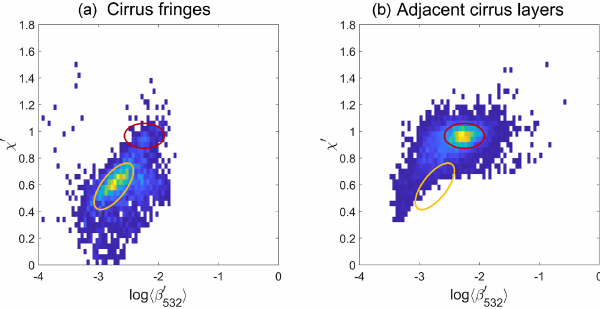
Figure 7. Layer-integrated attenuated color ratio, χ ’, vs. log 10 of (cid:105) ) , for layers the 532nm mean attenuated backscatter, log 10 ( (cid:104) β (cid:48) 532 identified as cirrus fringes (a) and for adjacent cirrus layers (b) . Or- ange probability contours for cirrus fringes and red probability con- tours for the adjacent cirrus are overlaid in both panels (a) and (b) . Both plots show nighttime data acquired between 40 ◦ N and 40 ◦ S during January, February, and December 2008. The layer-integrated volume depolarization ratios for all layers, both fringes and cirrus, are in excess of